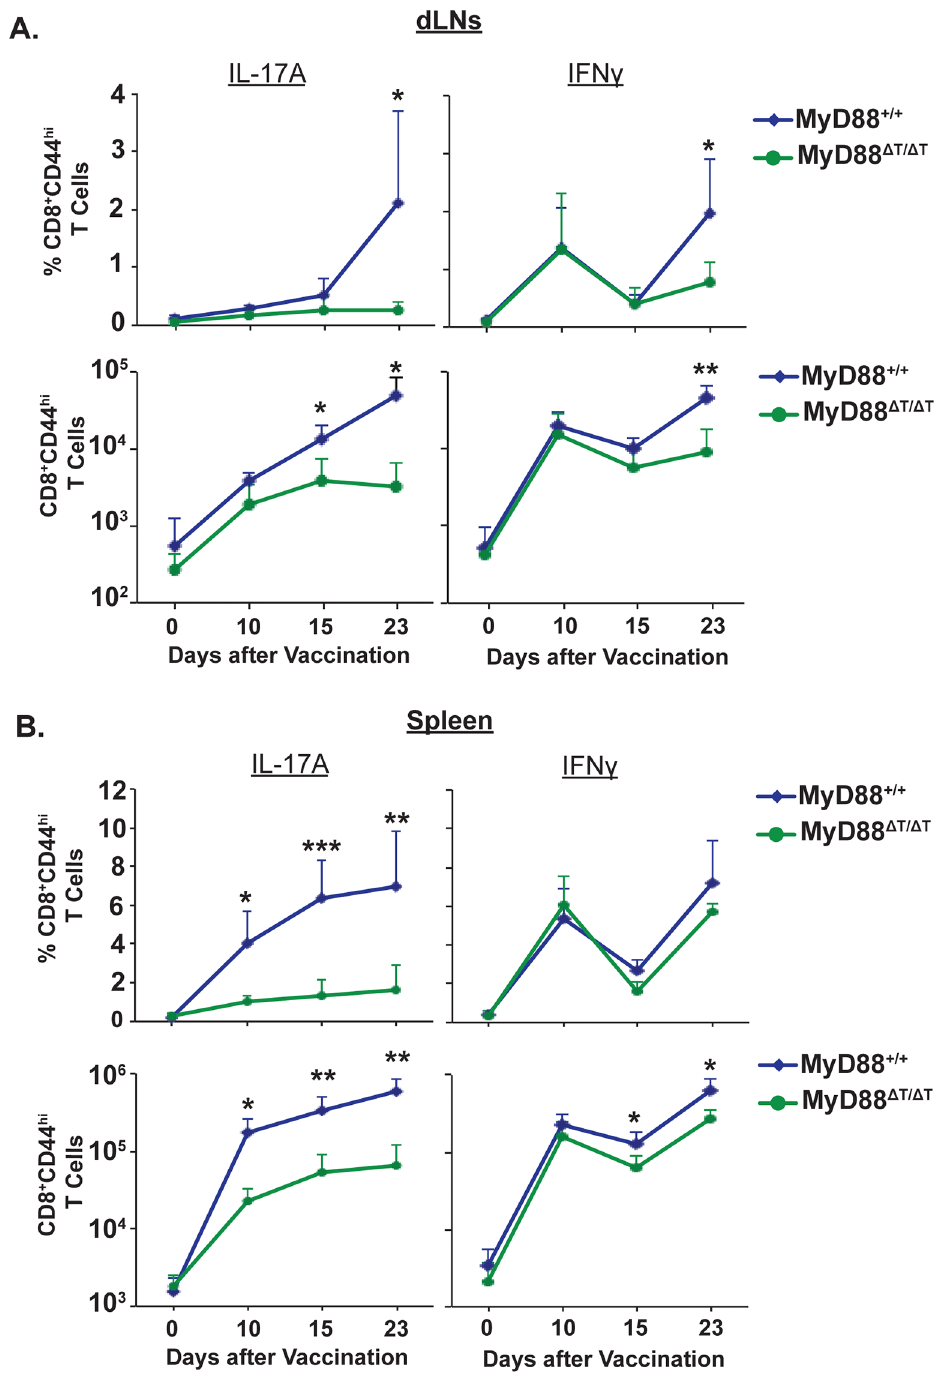
Fig 3. Kinetics of Tc17 and Tc1 cell responses in vaccinated mice. Na ï ve WT and MyD88 Δ T mice were vaccinated and on indicated days. dLNs (A) and spleens (B) were harvested to analyze percent and total number of IFN γ + and IL-17A + CD8 + T cells. CD4 + T cells were depleted throughout the experiment. Data are mean ± SD of N = 4 – 5 mice/group. * P (cid:1) 0.05.